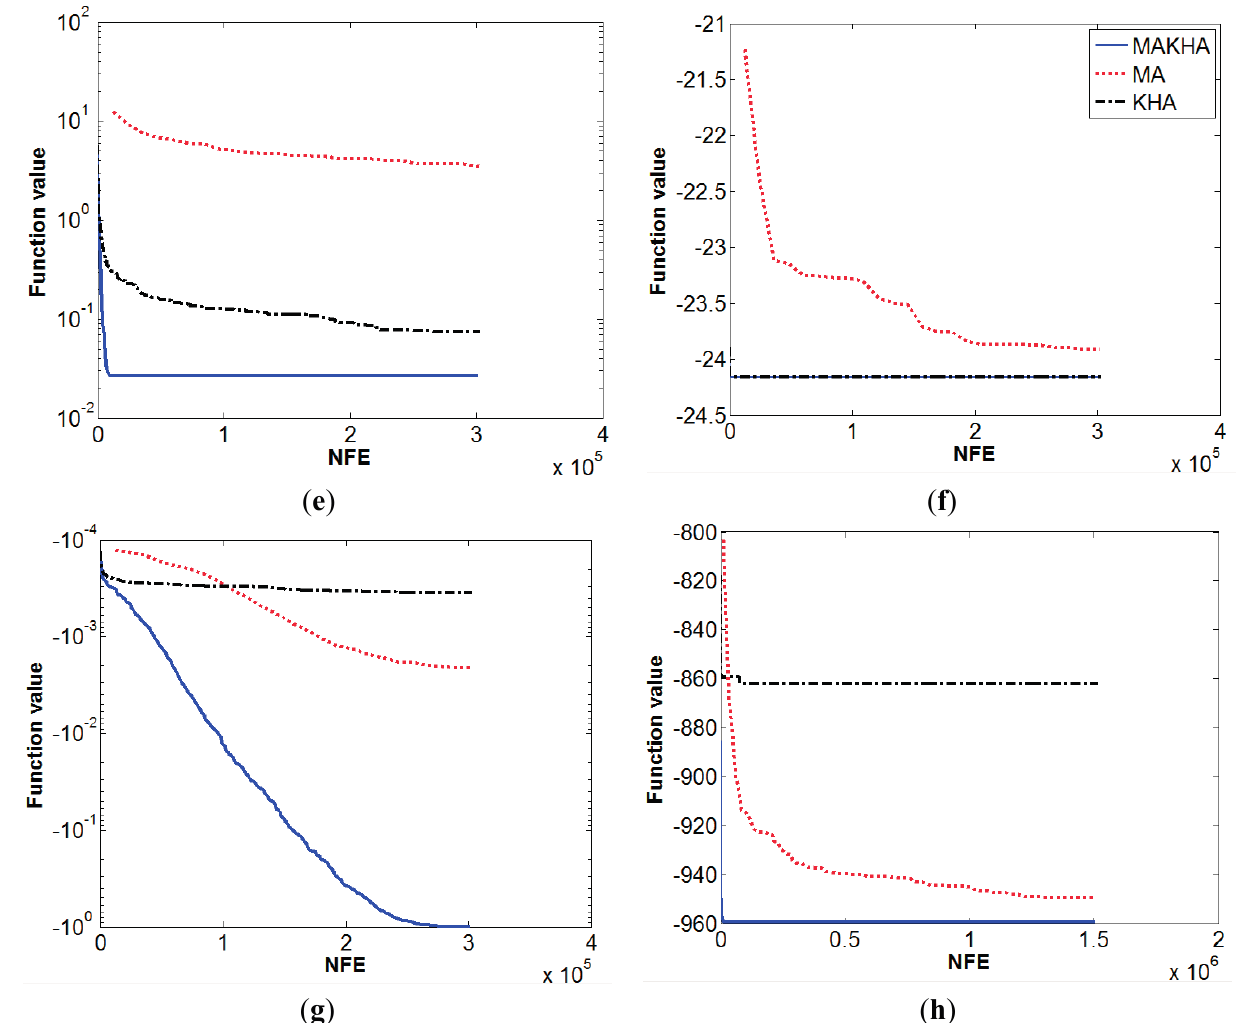
Figure 5. Evolution of mean best values for MA, KHA and MAKHA for: ( a ) Ackley, ( b ) Beale, ( c ) Bird ( d ) Booth, ( e ) Bukin6 ( f ) Carrom table, ( g ) Cross-leg table, and ( h ) Generalized Eggholder